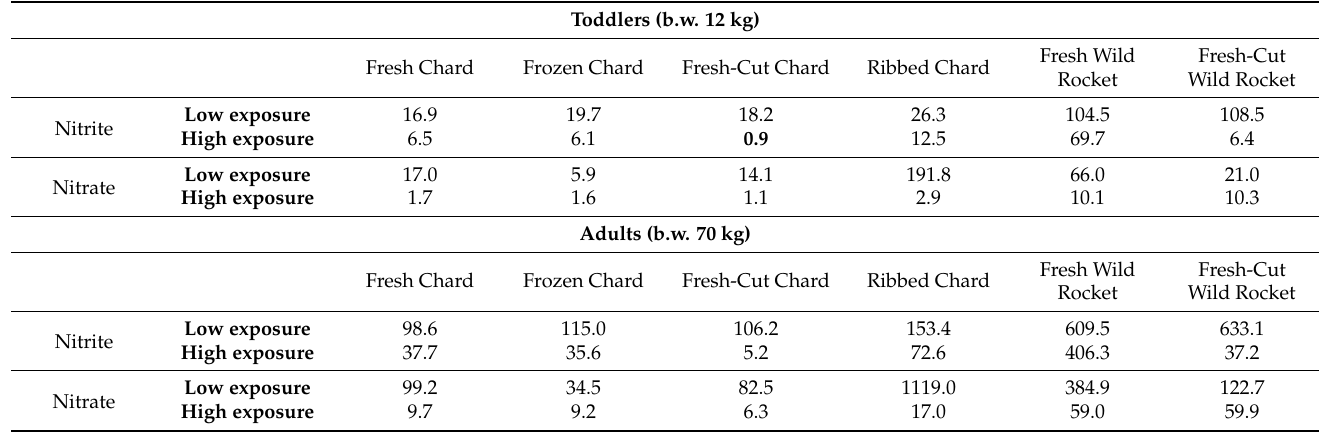
Table 3. Margin of Safety (MoS) for chard and wild rocket consumption under low- and high-exposure